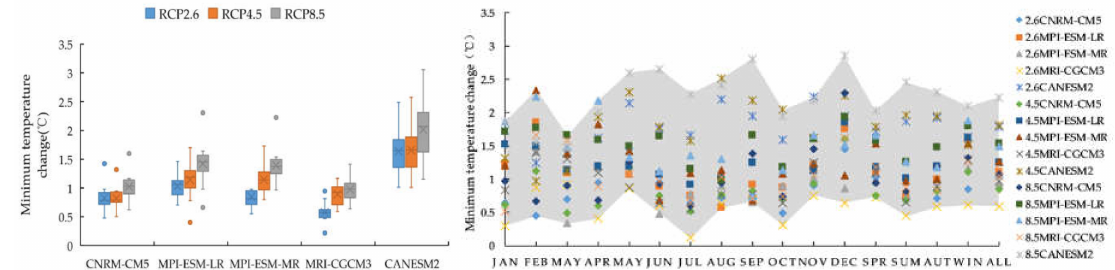
Figure 8. Multi-model projected change in mean maximum air temperature ( a ) in different RCP scenarios and ( b ) at different time scales in the Heihe River